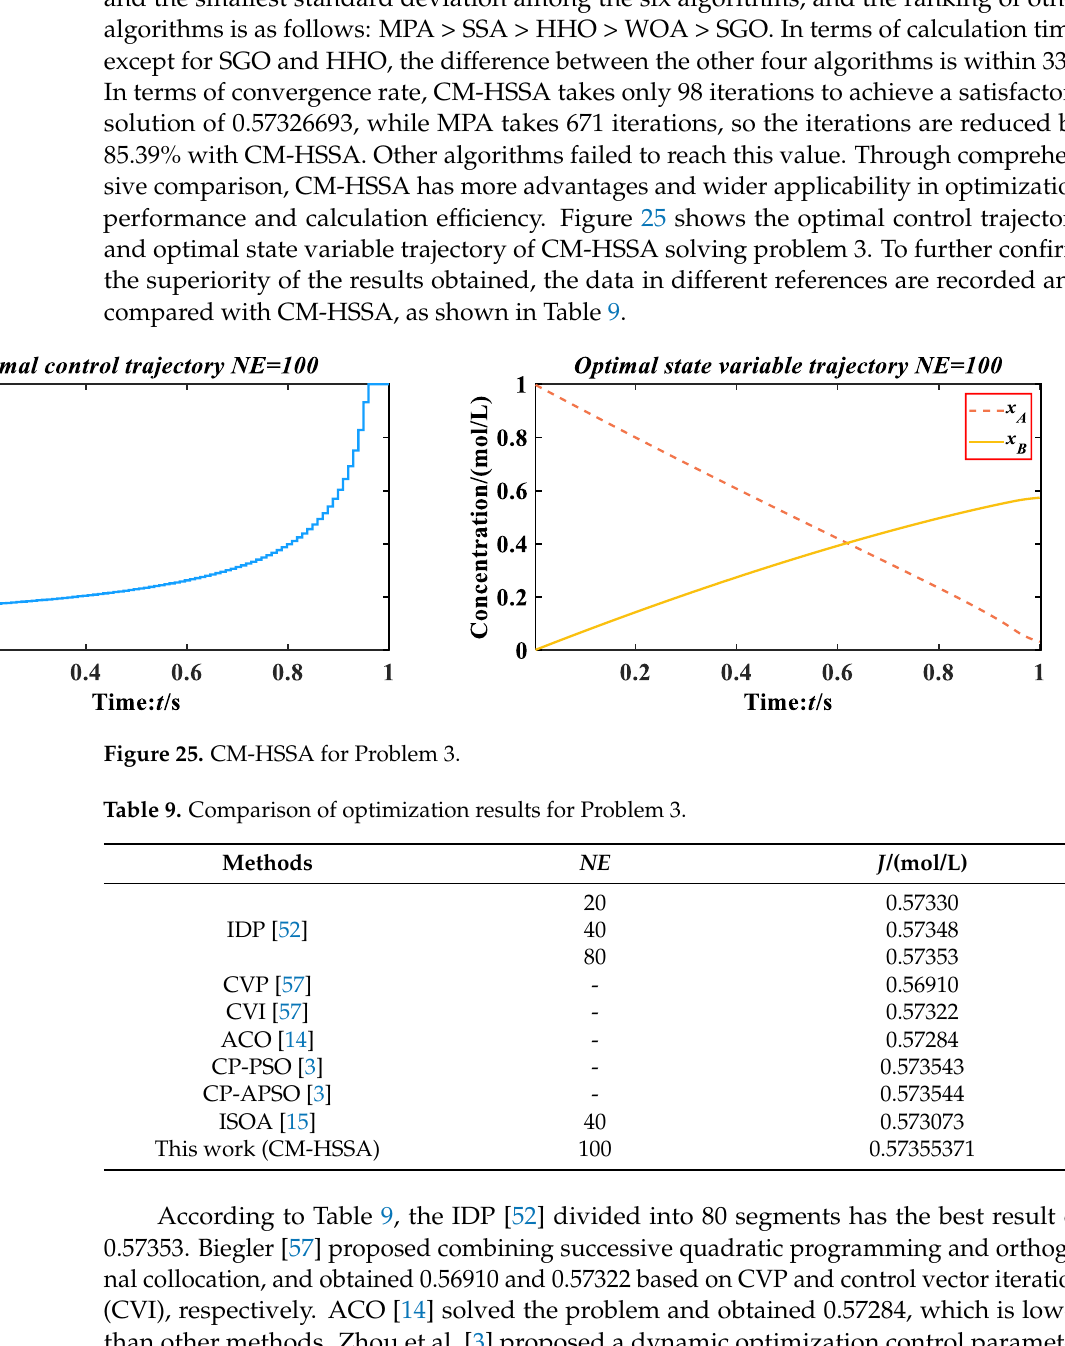
26 of 29 Figure 24. Iterative trajectories of six algorithms for Problem 3. Table 8. Comparison of optimization results for Problem 3. Method